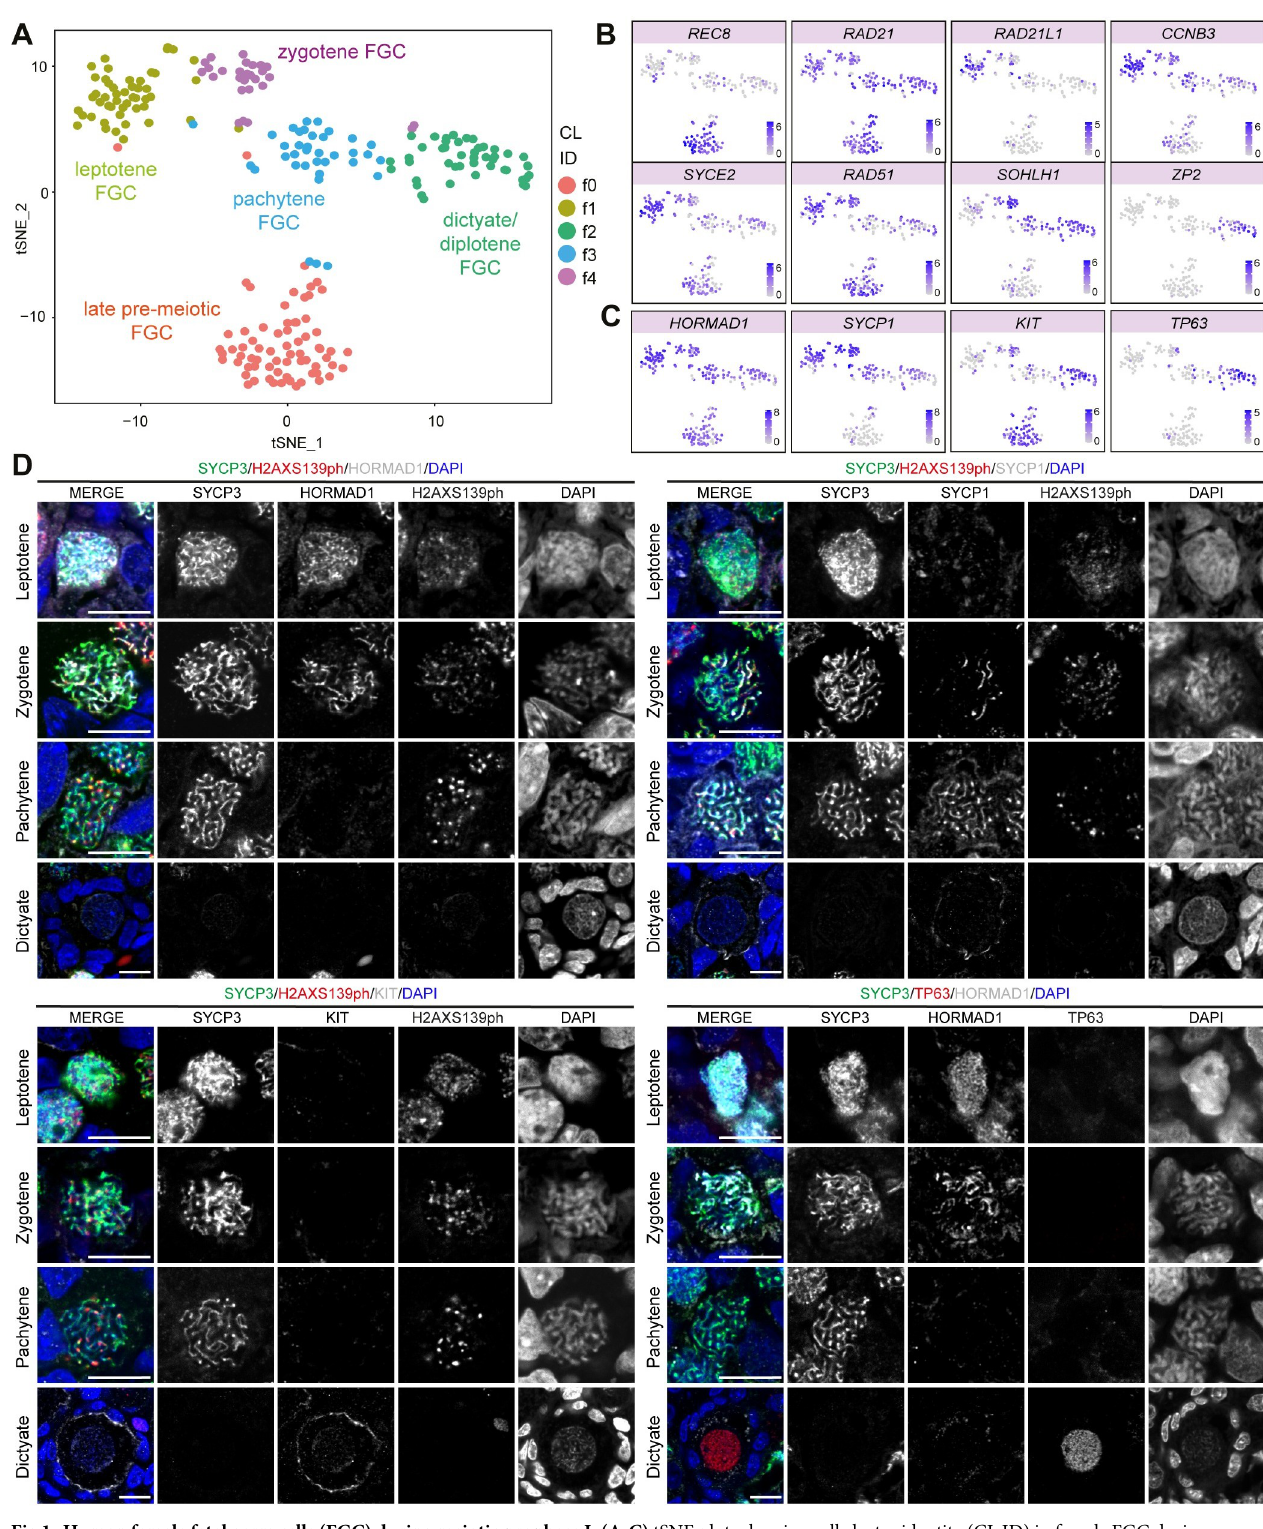
Fig 1. Human female fetal germ cells (FGC) during meiotic prophase I. (A-C) tSNE plots showing cell cluster identity (CL ID) in female FGC during meiotic prophase I (A) and depicting expression of known meiotic markers (B-C) . (D) Immunofluorescence of SYCP3, H2AXS139ph and selected fDEGs in leptotene, zygotene, pachytene and dictyate FGC in 14-18WPF ovarian sections. Scale bars are 10 μ m.